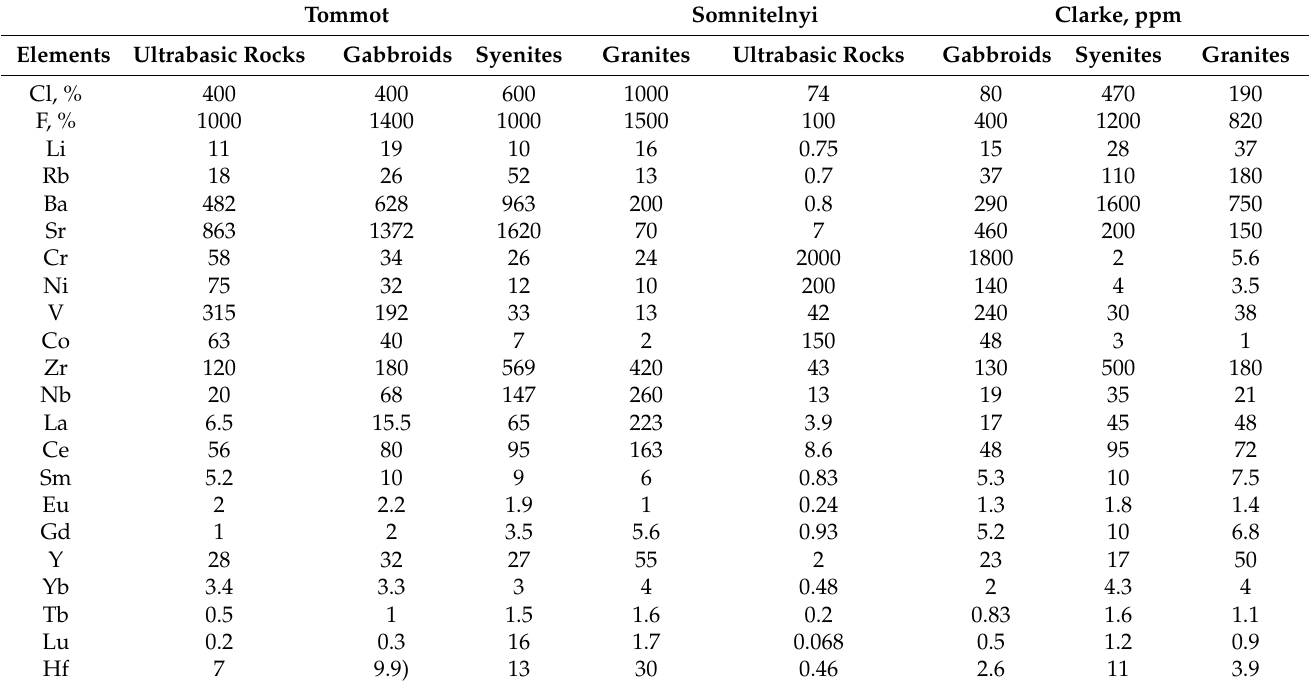
Table 3. Average contents of trace elements (ppm) in magmatic rocks of the Tommot and Somnitelnyi massifs [27] and Clarke values